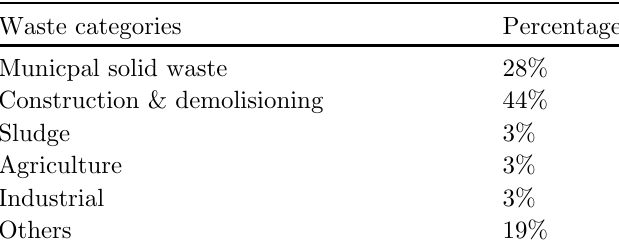
Table 3. Non-hazardous wast (2018 – 2019) [6].